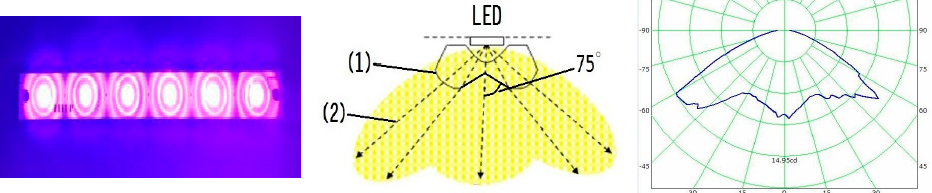
Figure 8. Comparison of luminous intensity distribution and ideal luminous intensity distribution of the SFL module with peak intensity angle 150°. (1) Refracting surface; (2) projection light passing through the SFL directly.